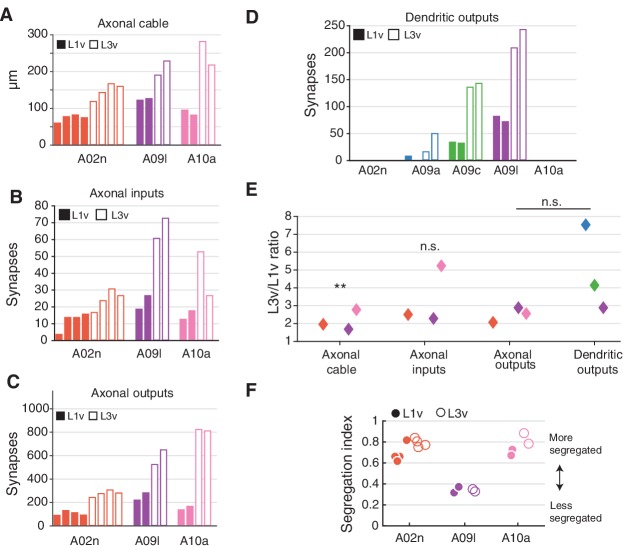
Additional LN properties.(A) Total axonal cable length for A02n, A09l, and A10a. The LNs A09a and A09c had incomplete axons in the L3v due to the limited extent of the image volume and are omitted from axon-related analysis here. (B) Number of synaptic inputs onto LN axons. (C) Number of axonal outputs for LNs. (D) Number of synaptic outputs on the dendrites of each LN. All neuron types that exhibited dendritic outputs in the L3v also had them in the L1v, suggesting that all of the basic categories of connections are preserved. (E) Fold-change between the L1v and L3v for the properties in A–D. Colors correspond to cell types. Axonal cable scales significantly less than dendritic cable (p=0.009, two sided t-test with Bonferroni correction), though other differences between axonal and dendritic property scaling are not significant. (F) Segregation index for complete LNs, which measures the degree of input/output segregation of a neuron (one indicates a completely segregated neuron, with all outputs in one region and all inputs in another; 0 indicated a neuron with completely intermixed inputs and outputs. See Materials and methods for precise definition.) Note that segregation index is generally maintained as a cell type-specific property across larval stages.